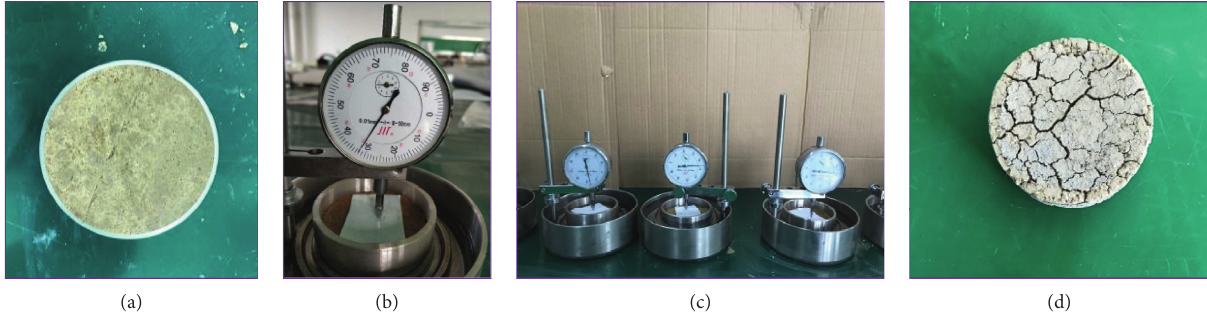
Figure 1: Test process. (a) Sample, (b) loading, (c) immersion, and (d) drying.